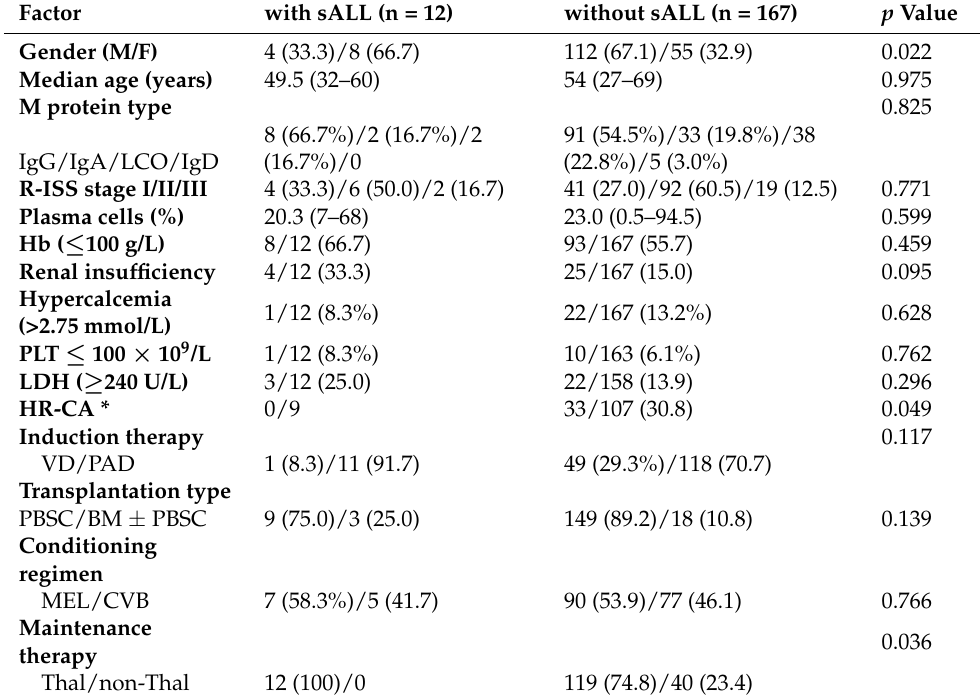
Table 1. The basic characteristics of patients with MM with sALL and without sALL [n